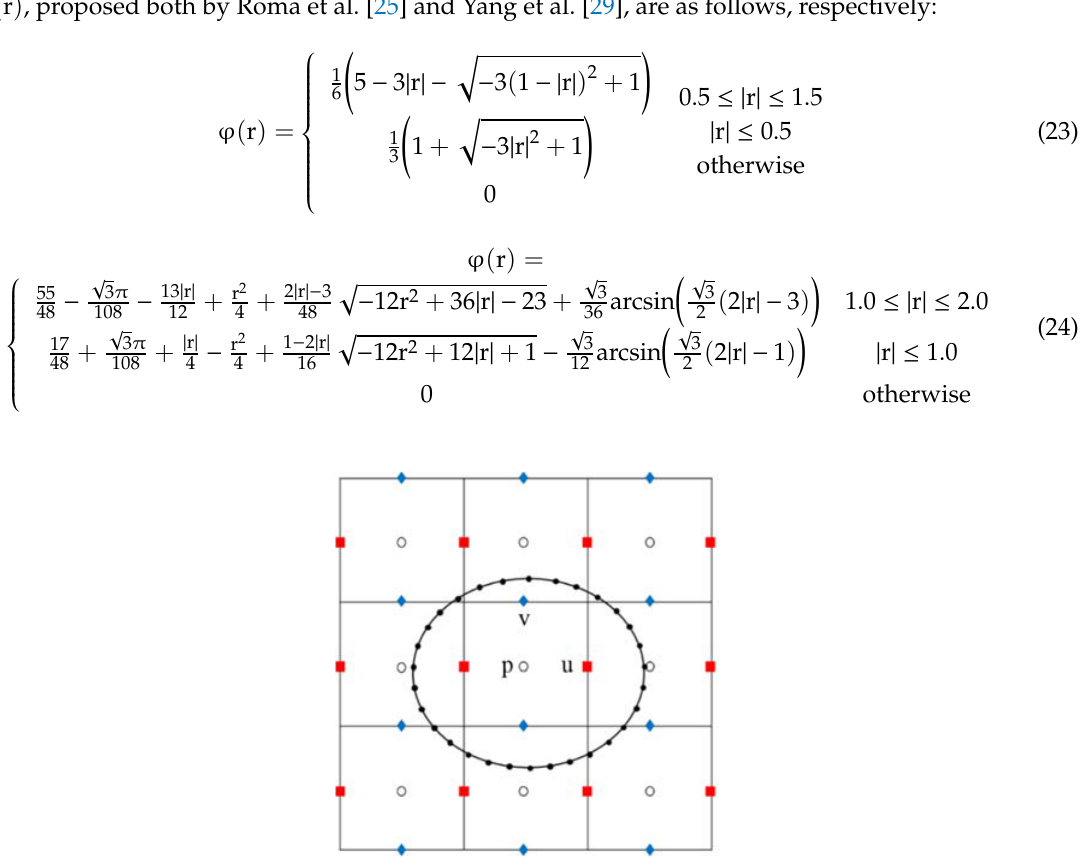
Figure 2. Arrangements of staggered Cartesian grid and embedded interface with marker points in a two-dimensional case.